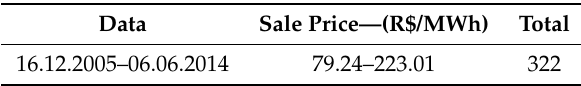
Table 1. Summary